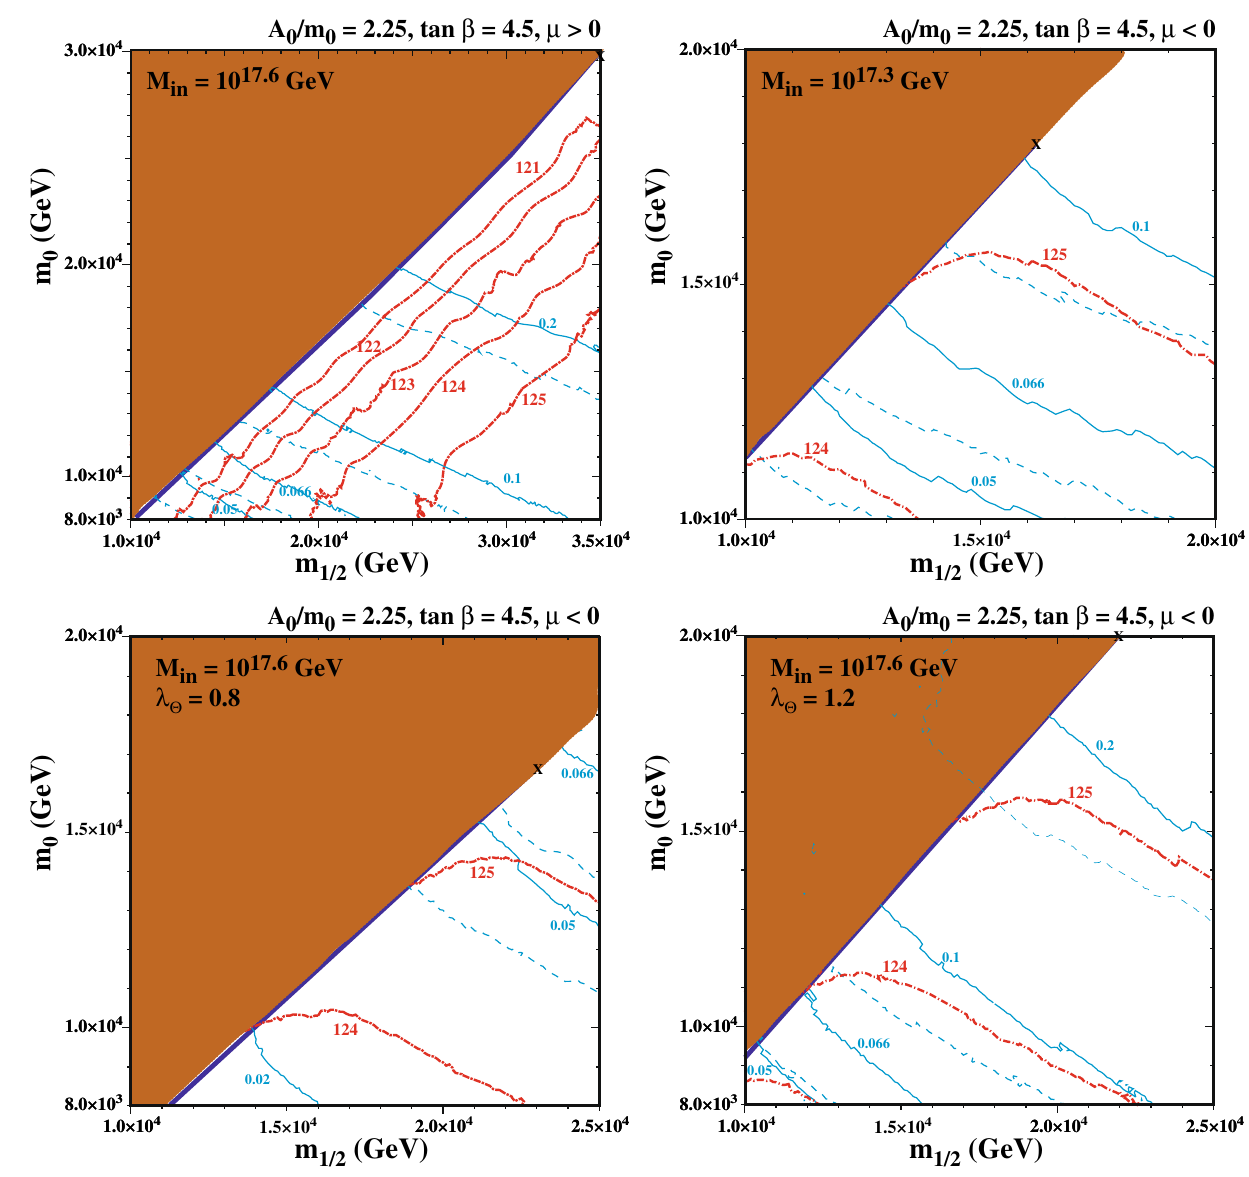
sponding planes with λ (cid:5) = 0 . 8 (left) and λ (cid:5) = 1 . 2 (right), with μ < 0, and M in = 4 × 10 17 GeVandunchangedvaluesoftheotherparameters. In each panel, the cross marks the endpoint of the stop coannihilation strip